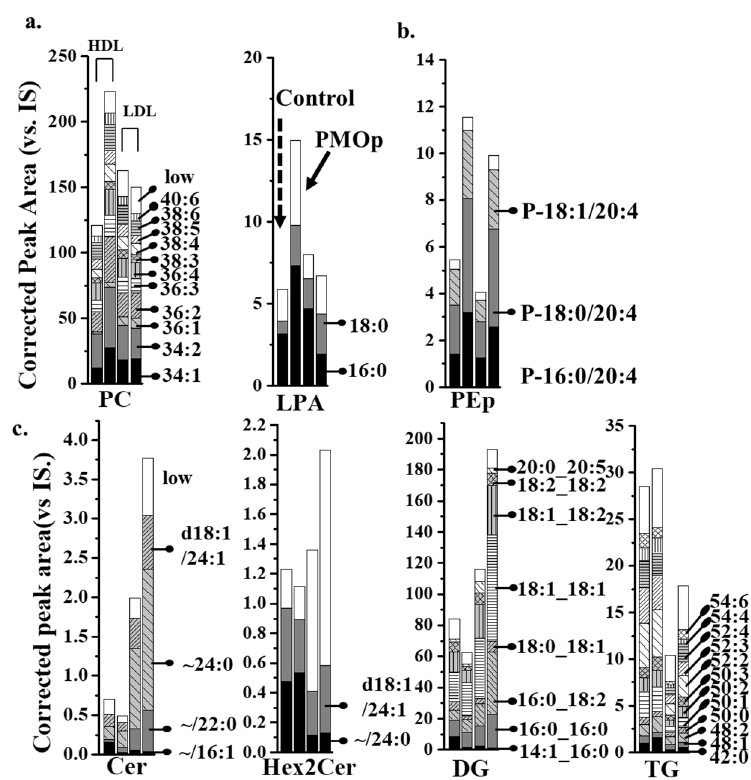
Figure 4. Stacked bar graphs of seven lipid classes showing significant changes (>1.5-fold and p < 0.05) in the total amount of lipids between the PMOp and control groups among 19 lipid classes: ( a ) >1.5-fold increase in only HDL of the PMOp group, ( b ) >1.5-fold increase in both HDL and LDL fractions, and ( c ) >1.5-fold increase in only LDL. The lipid species marked with acyl chain structures at the right of each bar are the relatively high-abundance species in each lipid class, and “low” represents the summed amount of the remaining low-abundance species.